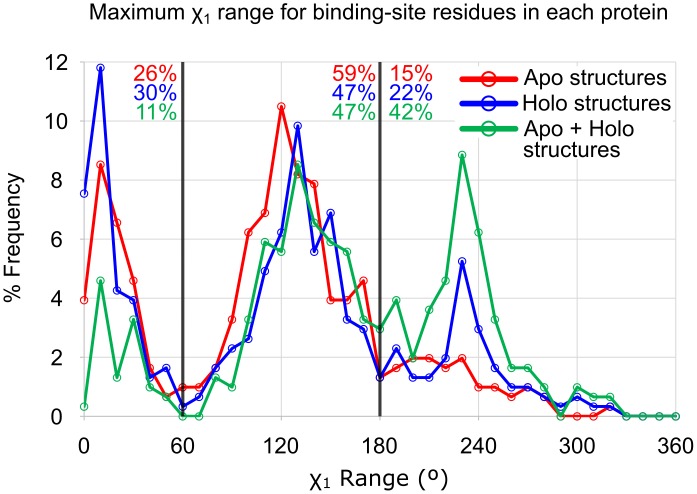
Distribution of the maximal χ1 range in each binding site.Again, the flexibility of the apo and holo states are approximately the same. When the structures are combined, much greater variation is seen in the maximum χ1 range. The ranges observed across the apo structures are shown in red, and the ranges across the holo structures are shown in blue. The line in green shows the χ1 ranges measured when the apo and holo structures are analyzed together (apo+holo). The population of structures with maximum χ1 ranges occupying one conformational well (0–60°), two wells (60°-180°), and all three wells (180°-360°) are given in red, blue, and green numbers for the apo, holo, and apo+holo analysis, respectively.